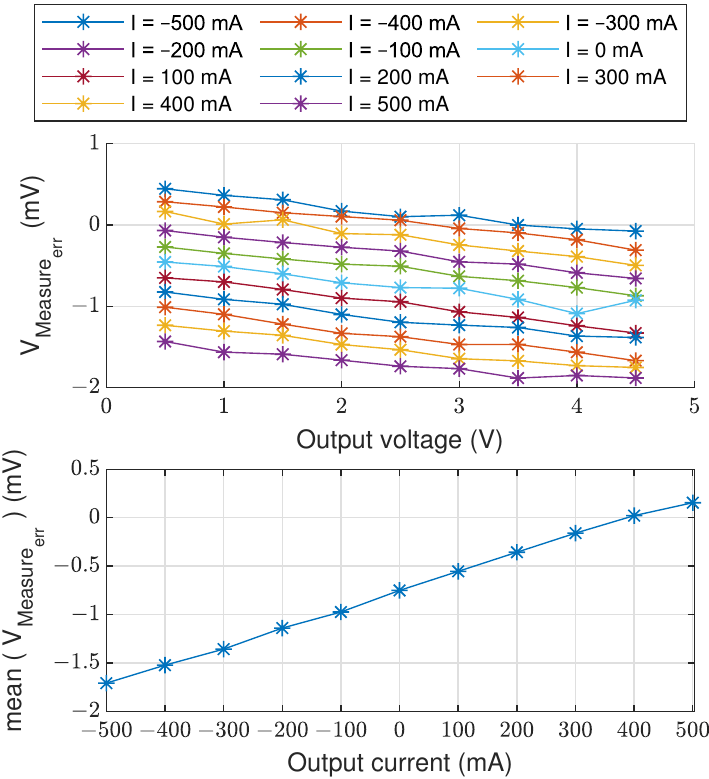
Figure 7. Characterization of the cell emulator measurement system with different cell current values. Error as a function of the output voltage for different output currents ( top ). Mean error as a function of the output current ( bottom